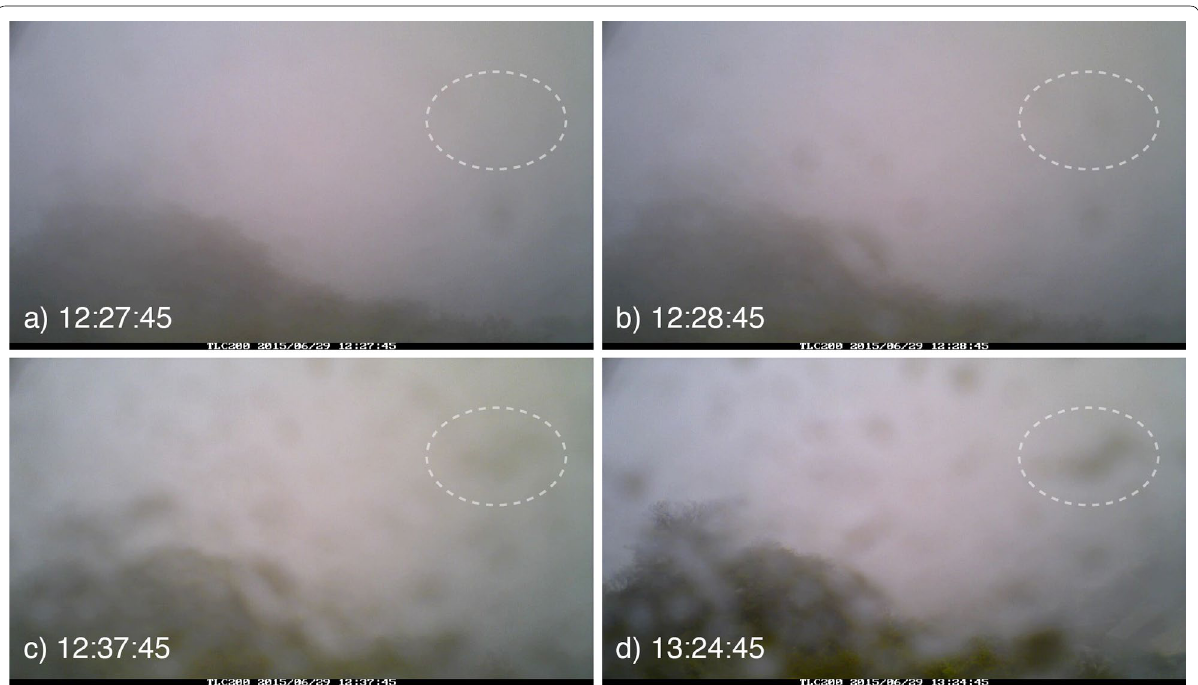
Fig. 11 Images taken by a time-lapse camera at around the time when ash fall was first observed on June 29, 2015. a The area of eruption was covered by dense fog but no rain fall was recognizable until 12:27. b Rain fall began at 12:28 and c covered whole camera view until 12:37. d The window surface began to dry; however, grime remained (13:24). The oval shows a reference area where a rain drop fell at 12:37 and remained as grime after the water evaporated. The camera was installed by HSRI (Fig.